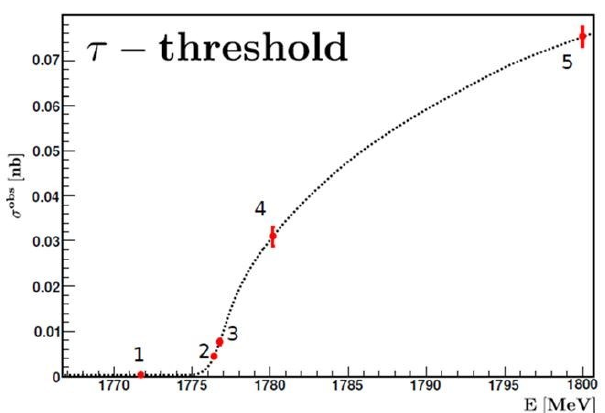
Figure 3: The dependence of observed cross section on the beam. The dots with error bar shows the expected measurements using the tau threshold scan